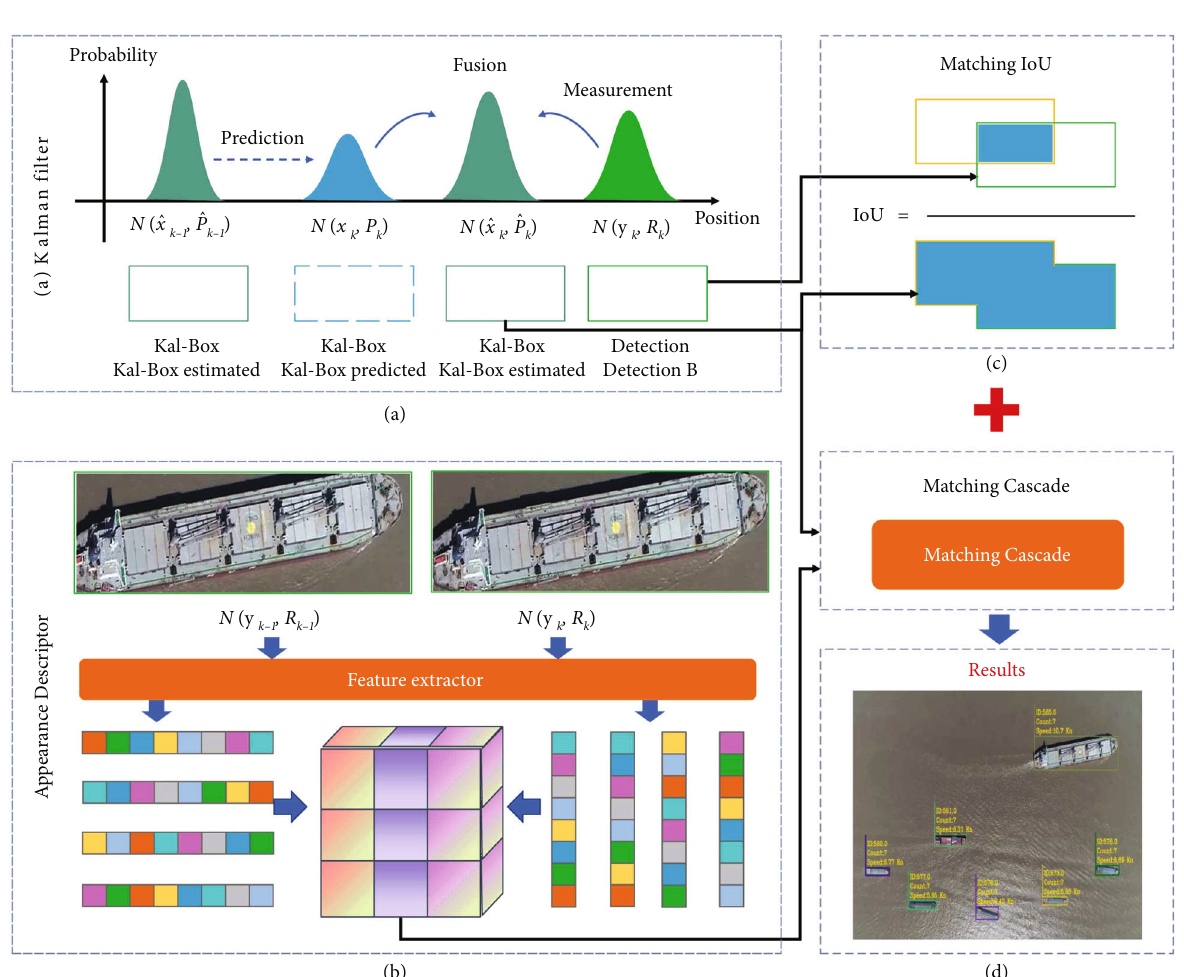
Figure 3: Schematic diagram of ship